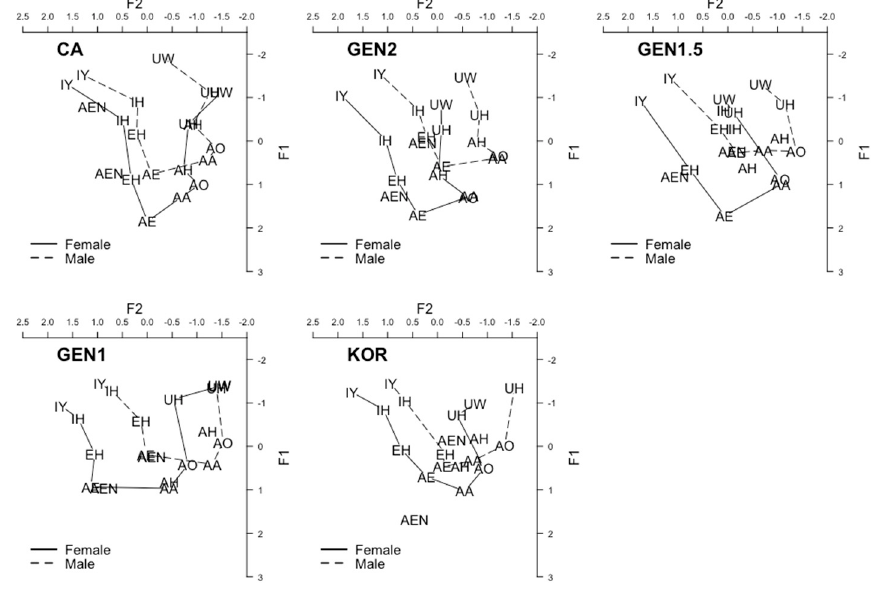
Figure 3. Normalized F1-F2 space by group and gender.